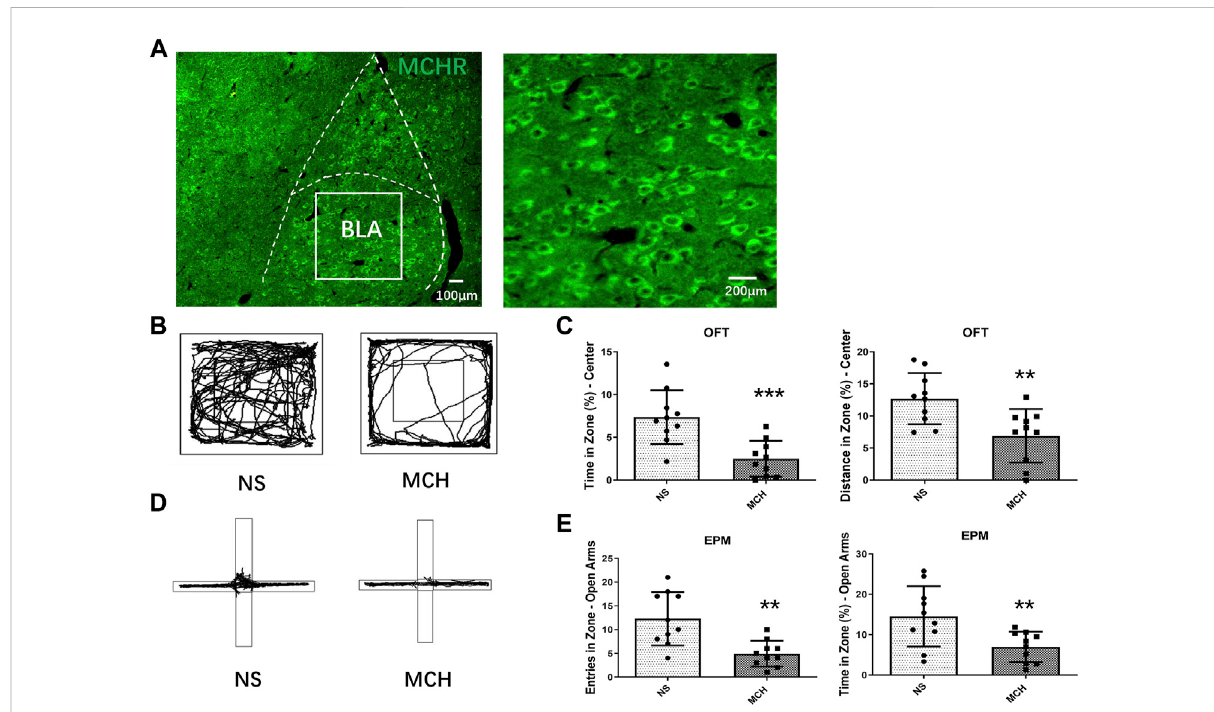
FIGURE 1 MCH peptide microinjection into the BLA induced anxiety-like behaviors in mice. (A) Fluorescent immunohistochemistry showed MCHR in the BLA. (B) RepresentativetracesoflocomotoractivityintheOFT. (C) EffectsofinjectingtheMCHpeptideintotheBLAonthecenterresidencetimeand distanceinthe.OFT. (D) RepresentativetracesoflocomotoractivityintheEPM. (E) EffectsofinjectingtheMCHpeptideintotheBLAontheopenarm entry times and residence time in the EPM. The data are presented as the mean ± SEM ( n = 10 mice per group). * p < 0.05, ** p < 0.01, *** p < 0.001 versus the NS